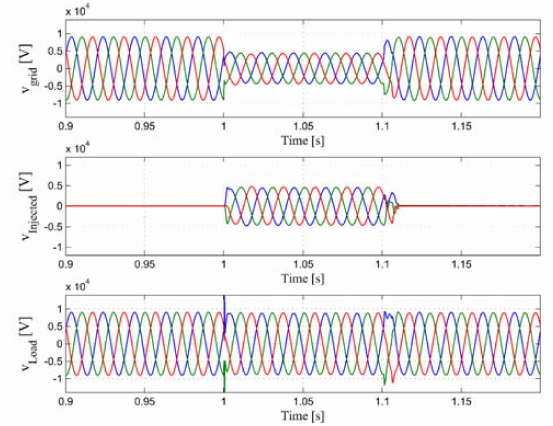
Figure 10. Case 1-Balanced voltage sag: grid voltage, injected voltage of the DVR and load